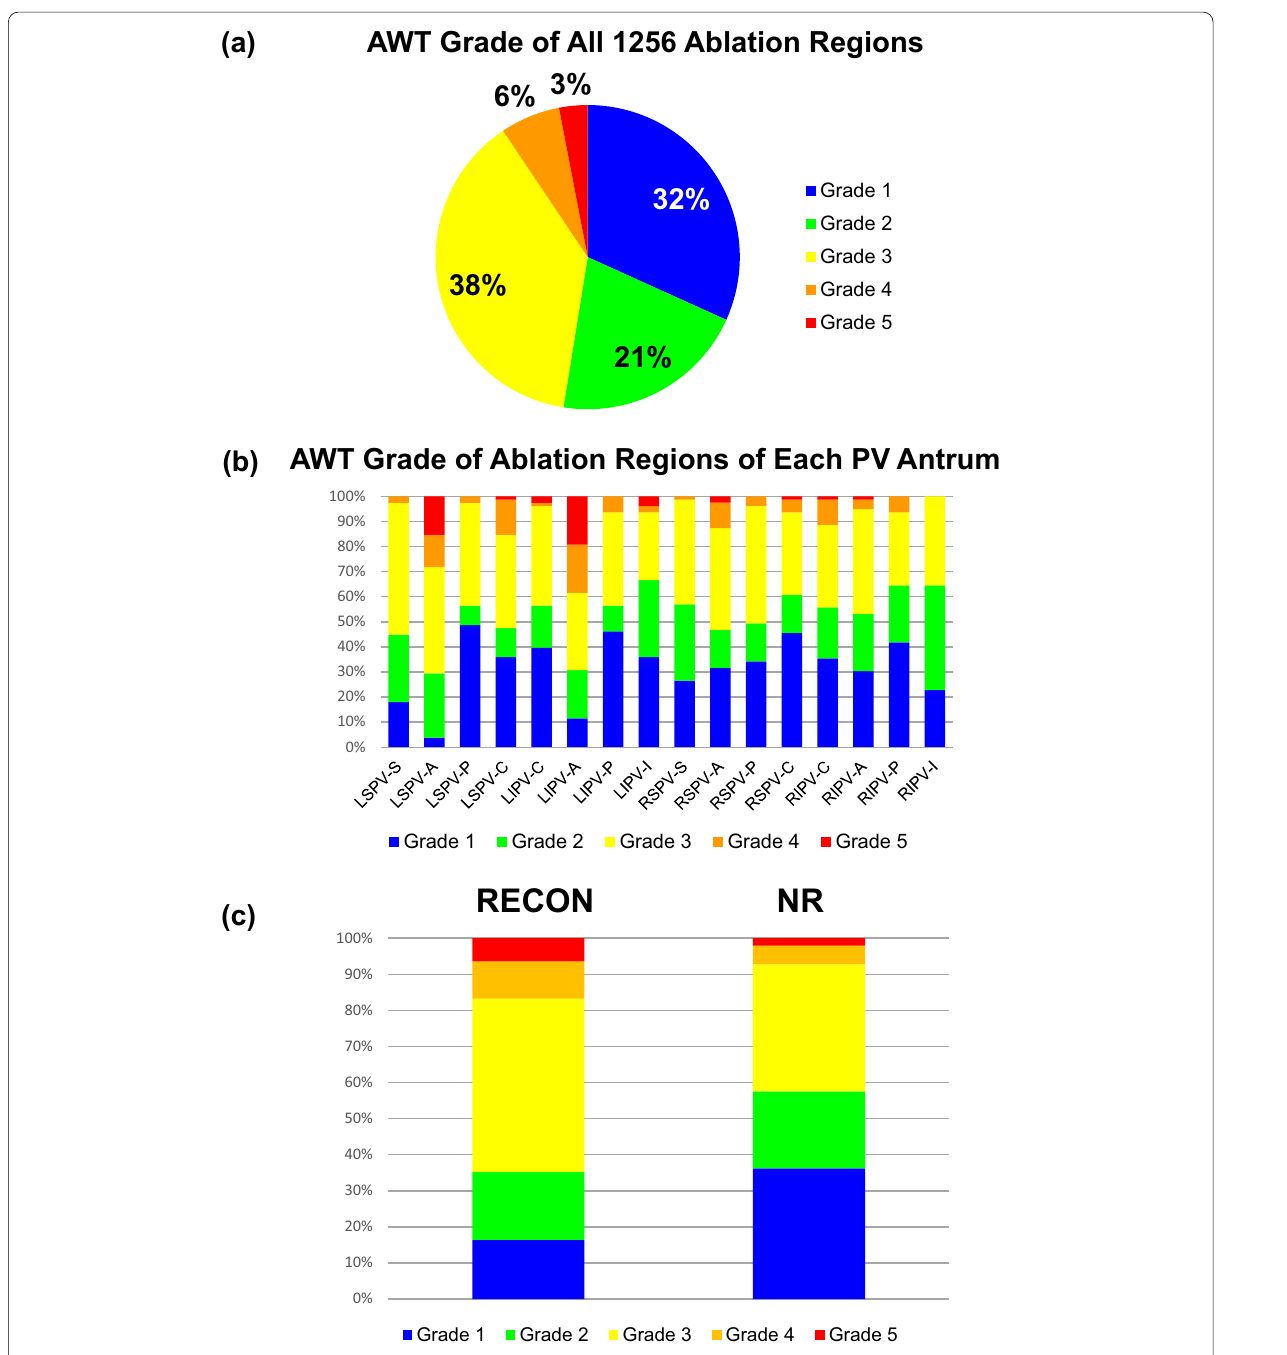
Fig. 3 Atrial wall thickness of PV antrum. Distribution of AWT grades of overall 1256 ablation segments ( a ) and ablation segments of each PV antrum ( b ). ‑S, superior segment (e.g., LSPV‑S, superior segment of LSPV); ‑A, anterior segment; ‑P, posterior segment; ‑C, carina segment; ‑I, inferior segment. c Distribution of AWT grades. AWT atrial wall thickness, RECON reconnected segments, NR non‑reconnected segments. All diagrams were generated by Excel 2016 (Microsoft, Redmond,